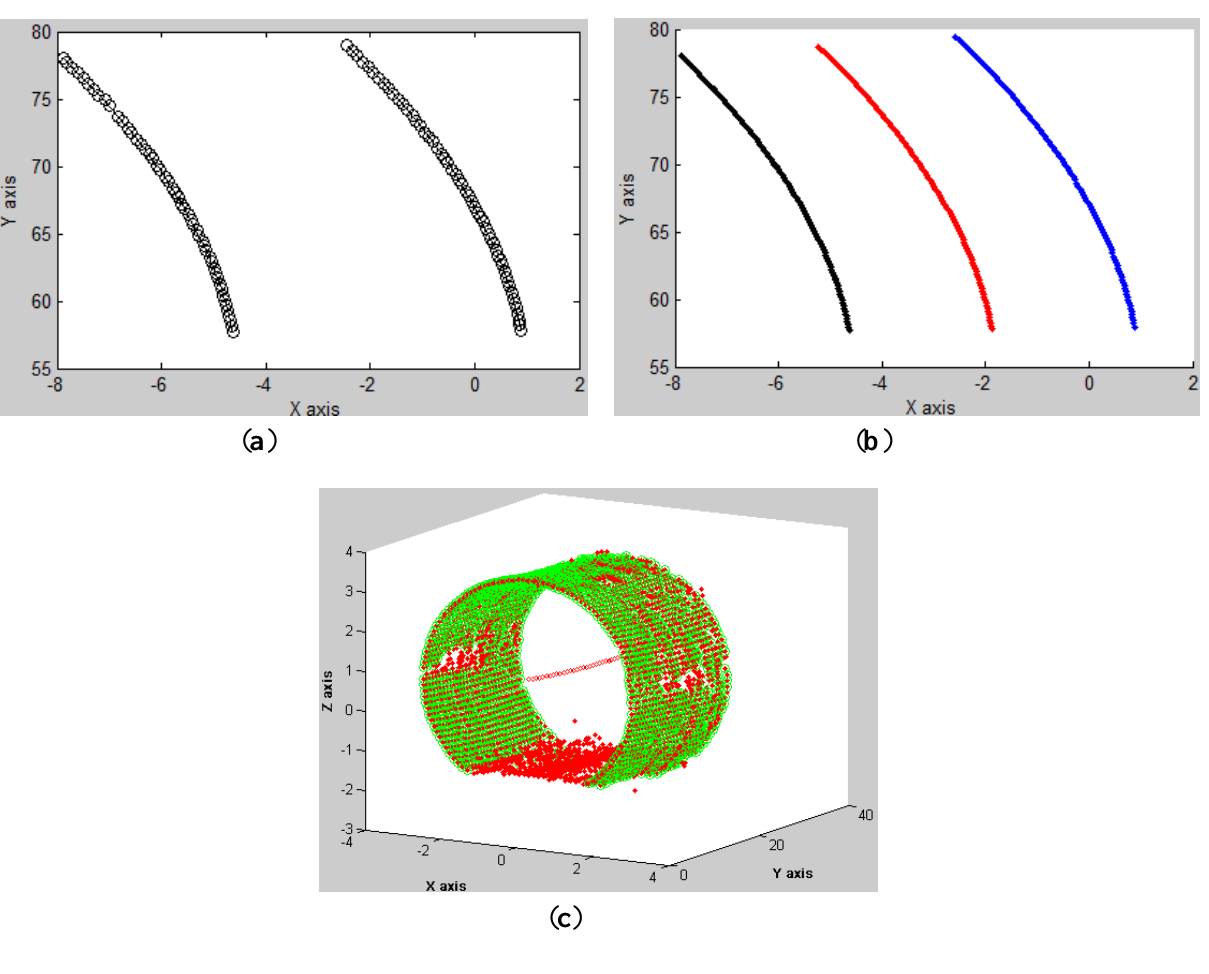
Figure 12. Extracted central